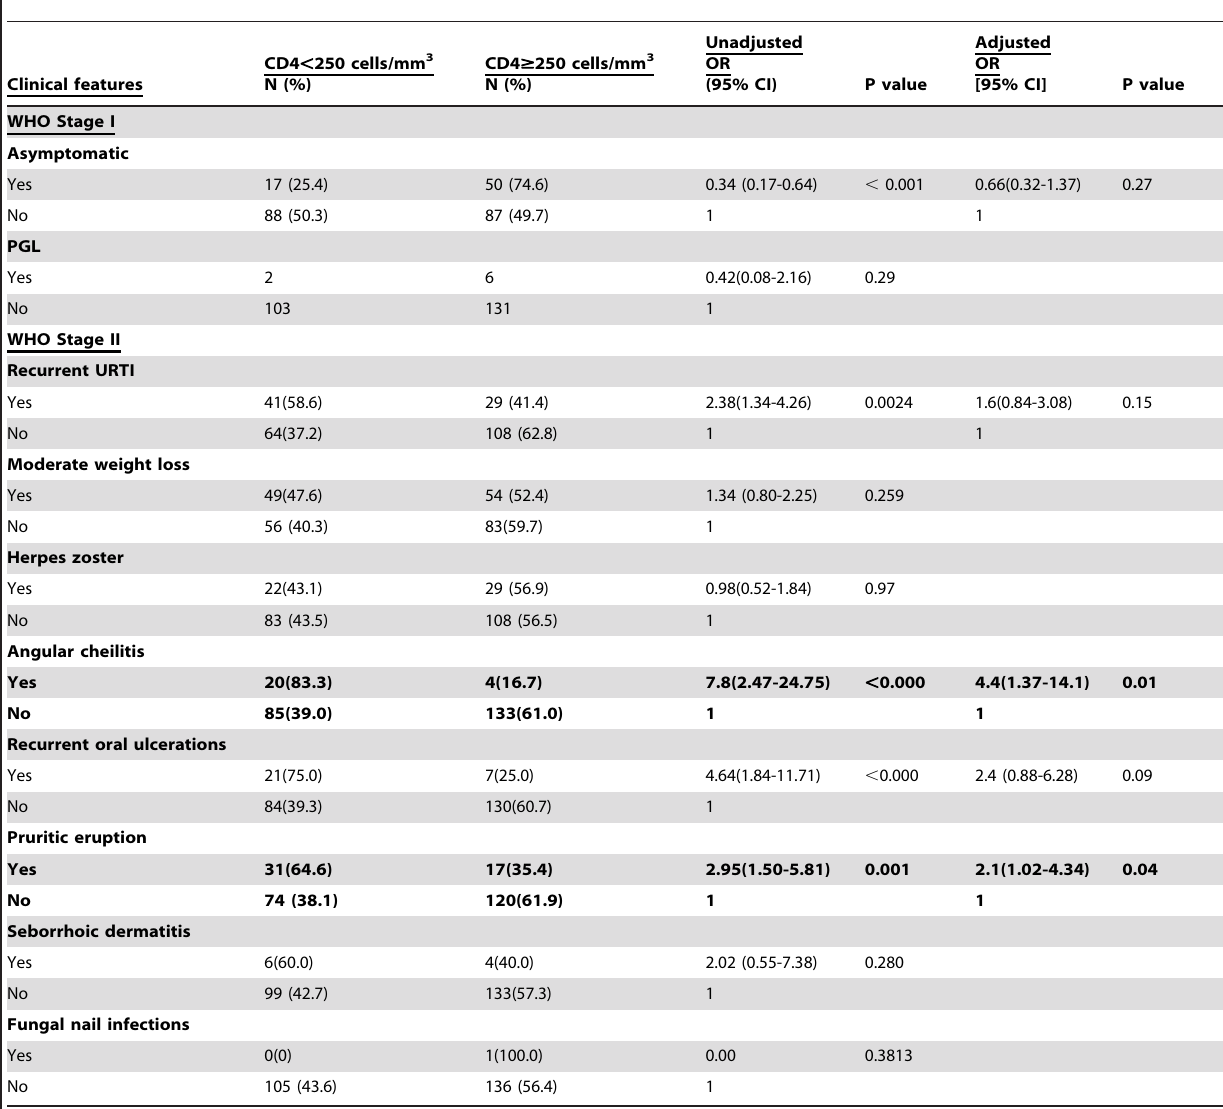
Table 3. Association between CD4 cell count , 250cells/mm 3 and the clinical features of the WHO HIV/AIDS clinical Stages I and II for the 242 participants in stages 1 and